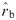
Indirect range restriction (IRR): Root mean square error (RMSE) of the estimates of the predictive validity (r^b and r^pb).r^b is the estimate of the biserial correlation coefficient for an artificially dichotomous criterion variable, and r^pb is the estimate of the point-biserial correlation coefficient for a naturally dichotomous criterion variable.